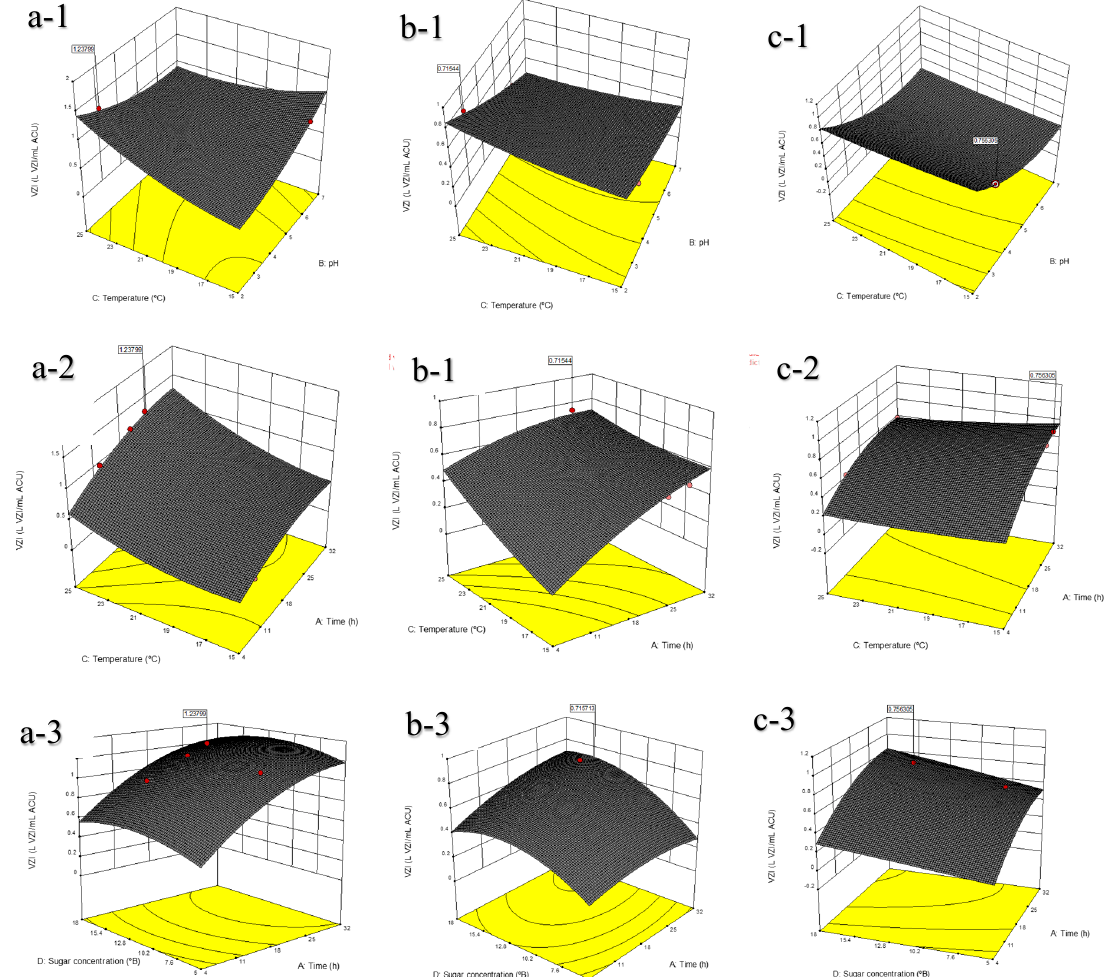
Figure 4. The combined effect of fermentation time and pH (1), time and incubation temperature (2), time and sugar concentration (3) on production of potential biopreservation compounds by Candida pyralidae Y1117 ( a ), Pichia kluyveri Y1125 ( b ) and P. kluyveri Y1164 ( c ). An example: the description, (a-1), represents a = C. pyralidae Y1117 and (1) = fermentation time and pH effects.